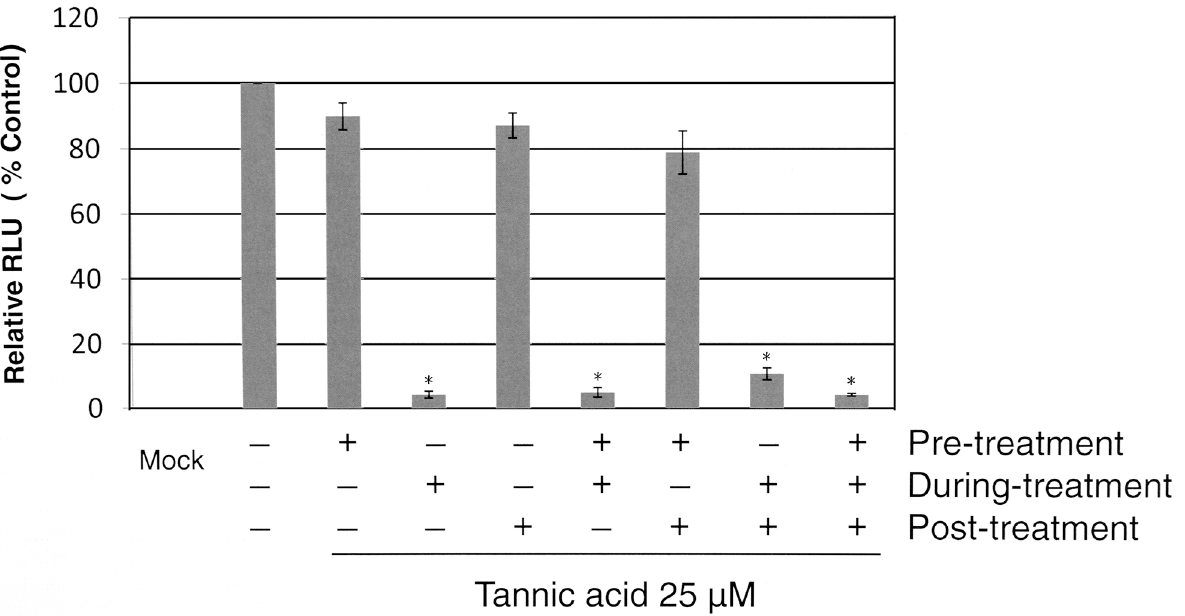
Fig 3. Tannic acid inhibits an Early Step of HCV Infection. Tannic acid 25 μ M was added to the culture medium of Huh7.5 cells for two hours before infection (pre-treatment), for two hours during infection (during-infection), and for two hours after infection with JFH1-AM120Rluc virus (post infection). Forty- eight hours post infection, cells were lysed and luciferase activity was measured. Infectivity is expressed as a percentage relative to luciferase activity measured in controls without tannic acid. Mock infection was the negative control. Mean values ± SD of three different experiments done in triplicate are presented. Results with a Student ’ s t -test P value < 0.01 are indicated by an asterisk.